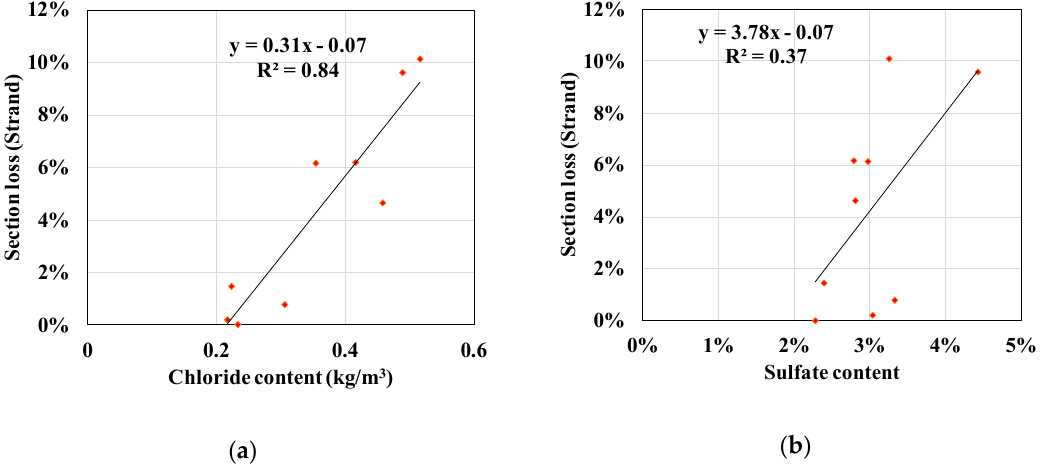
Figure 7. Relationship between chemical state of grout and section loss of strands due to corrosion: ( a ) chloride content to section loss, ( b ) sulfate content to section loss.